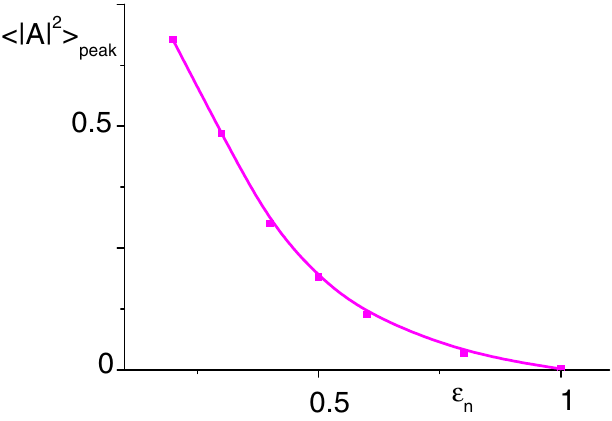
FIG. 4. (Color) hj A j 2 i same case of Fig. 1 and with (cid:4) !=! (cid:4) (cid:1) 10 (cid:1) 4 , w (cid:4) 0 : 3 , (cid:4) (cid:6)=(cid:6) (cid:4) 10 (cid:1) 4 a L 0